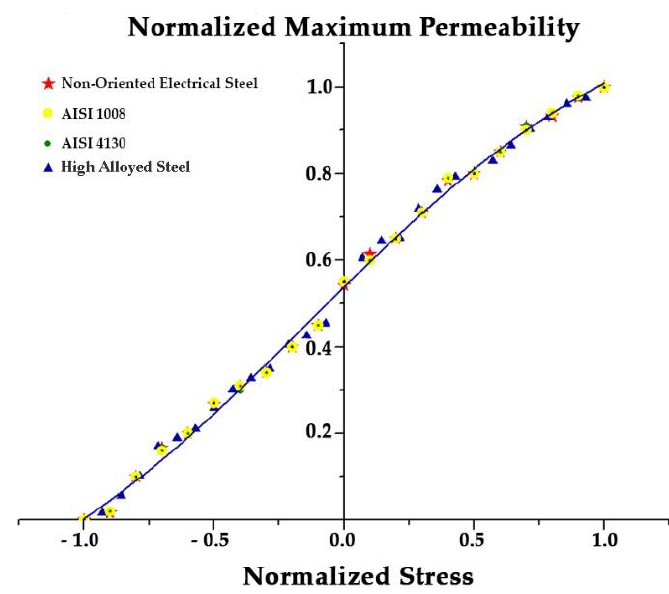
Figure 3. Normalized maximum differential permeability vs. normalized stress for the examined steel grades.